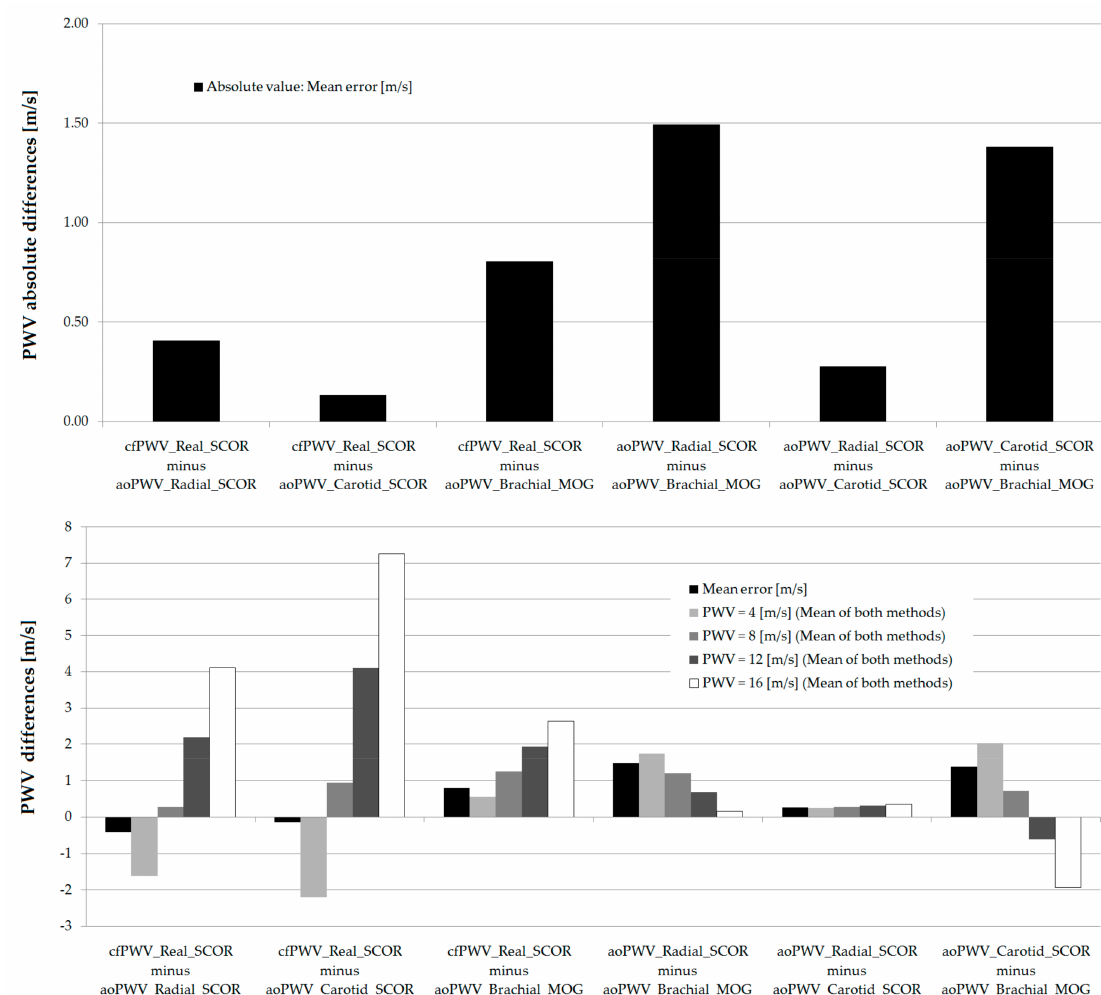
Figure 7. Top : Mean error (absolute value) for PWV data from different methods (Bland–Altman analysis). Bottom : Mean error and proportional differences for PWV equal to 4, 8, 12 and 16